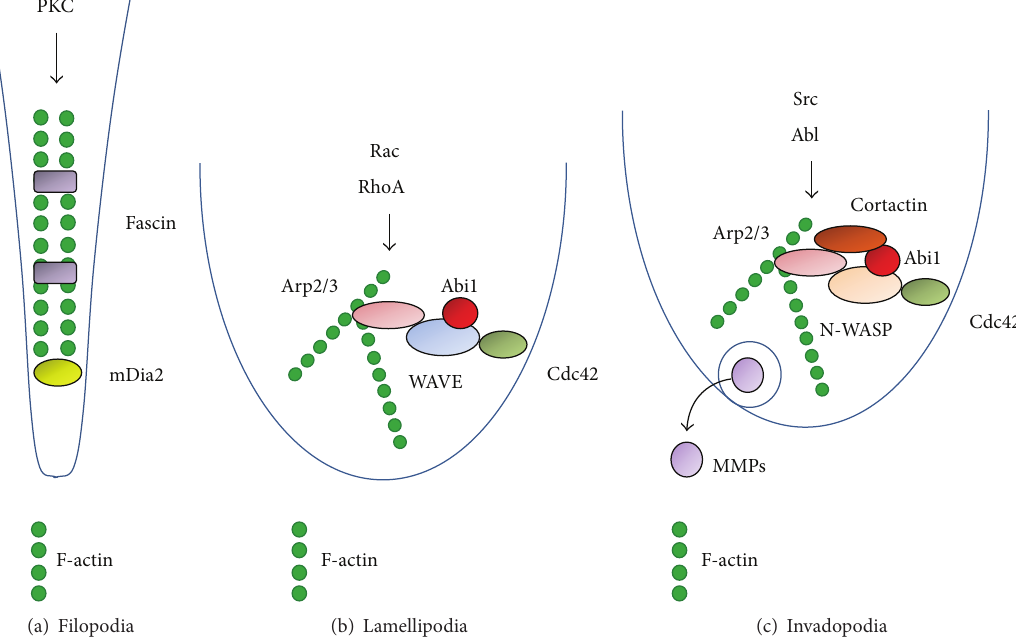
Figure 1: Simplified and schematic display of specialized cellular protrusions and key protein regulators involved in their formation and maintenance. (a) Filopodia consist of parallel actin filaments, which are formed by mDia2 upon Cdc42/protein kinase C signaling activity and then bundled by Fascin. (b) Rac/RhoA and/or Cdc42 signaling activates the WAVE complex, which, together with coregulators such as Abi1, stimulates Arp2/3-mediated actin branching and lamellipodial protrusion. (c) Invadopodia formation is mediated via N-WASP- mediated activation of Arp2/3 downstream Cdc42 signaling and might be further modulated by intracellular tyrosine kinase activity (Src, Abl). Furthermore, invadopodia secrete matrix metalloproteinases (MMPs) to degrade the extracellular matrix as a prerequisite for migration and